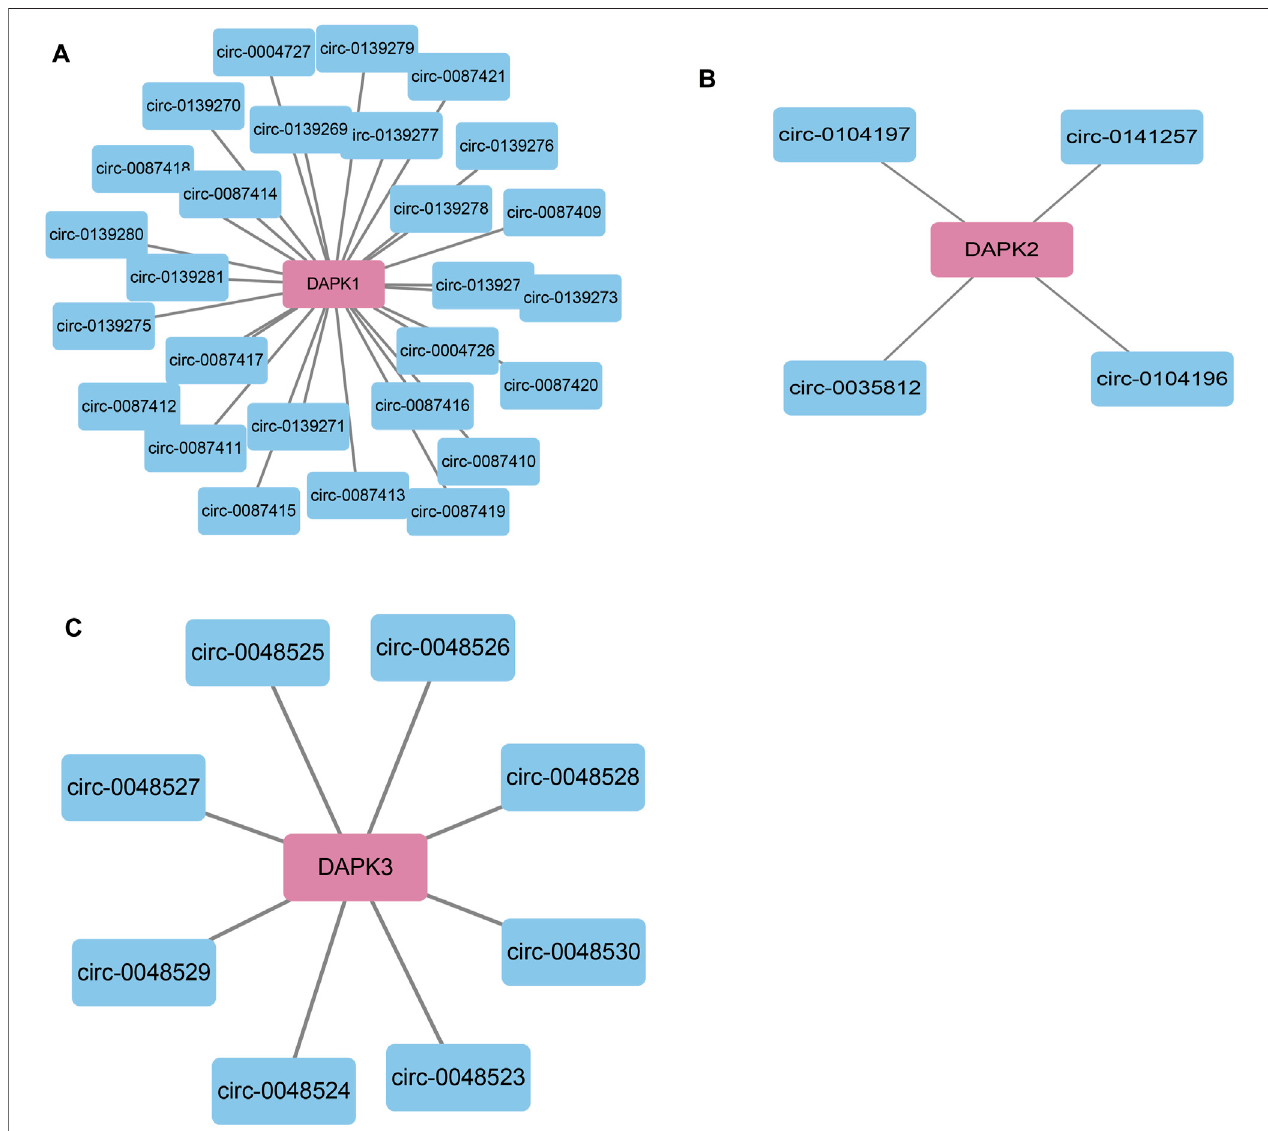
FIGURE 6 | Bioinformatics analysis of potential circRNAs in the regulation of DAPKs. Bioinformatics analysis of potential circRNA in the regulation of DAPK1 (A) , DAPK2 (B) and DAPK3 (C) .